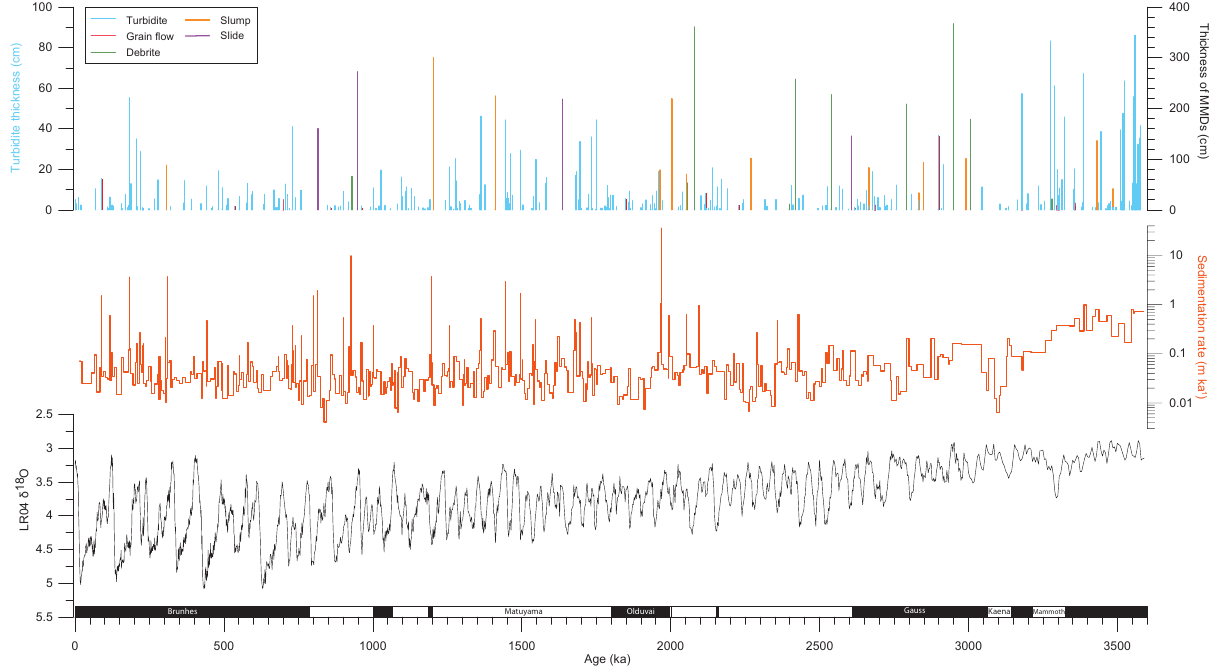
Fig. 9. Thickness of various MMDs compared with sedimentation rate and the LR04 global marine isotope stack (Lisiecki and Raymo, Fig. 9.